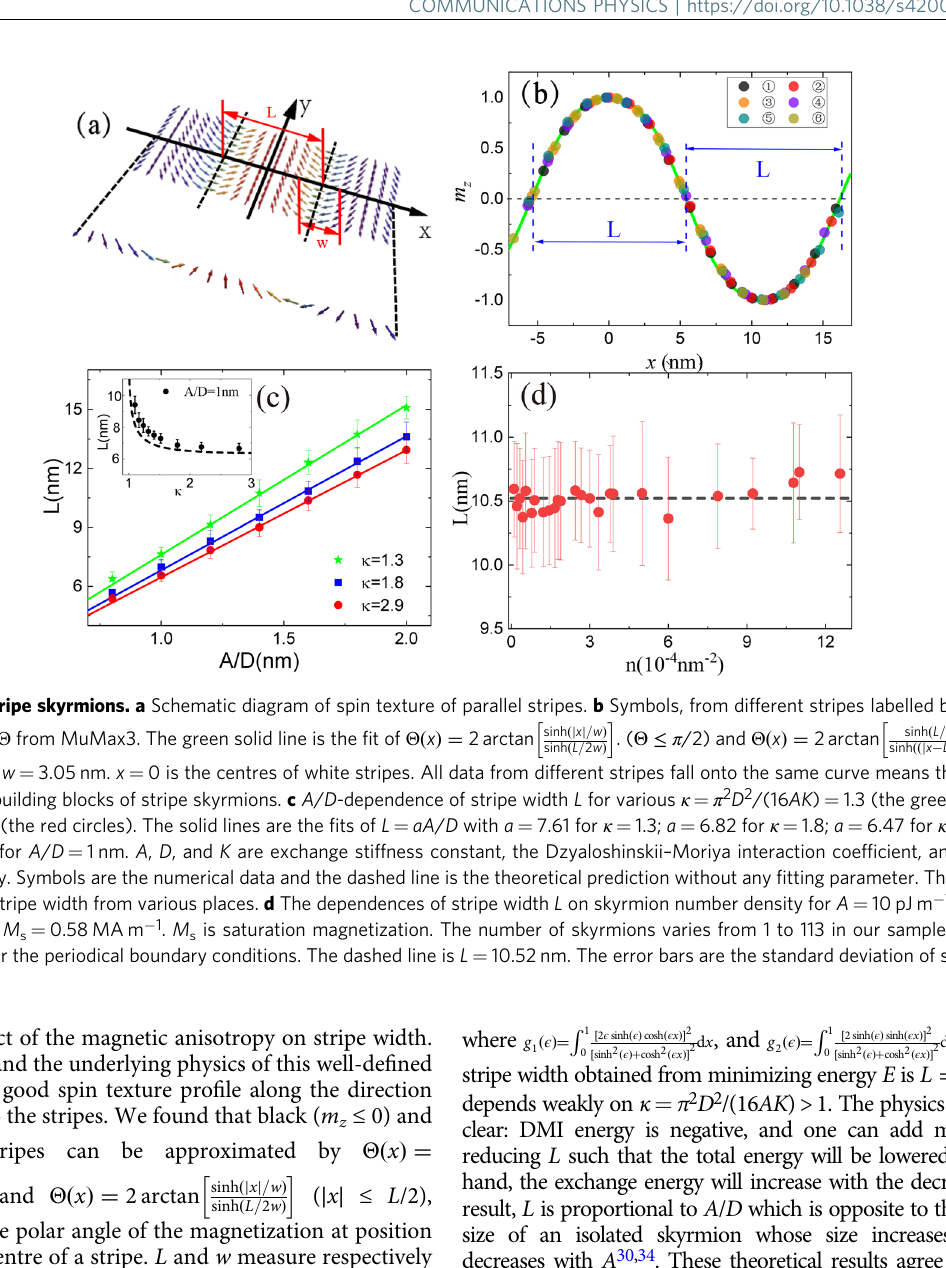
Fig. 3d. For the case of 100 skyrmions, some of them have